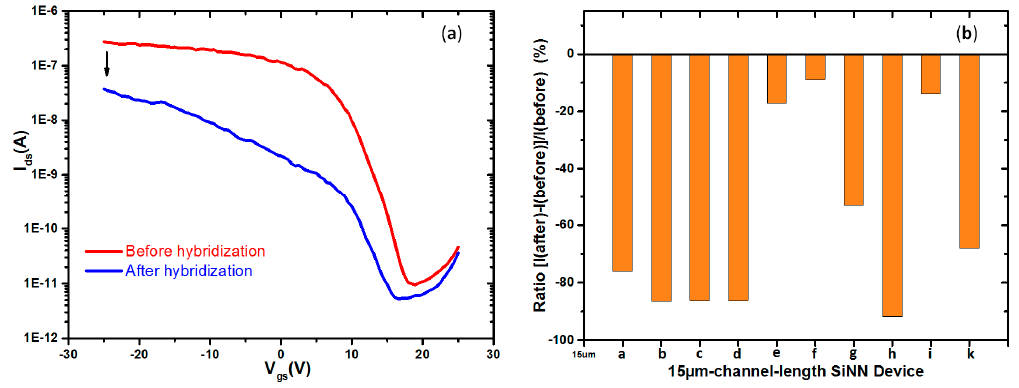
Figure 4. ( a ) Electrical response of SiNN FET before and after hybridization; ( b ) ON-state current ratio of ten 15 μ m-channel-length SiNN FETs before and after hybridization, the letter refers to the measured